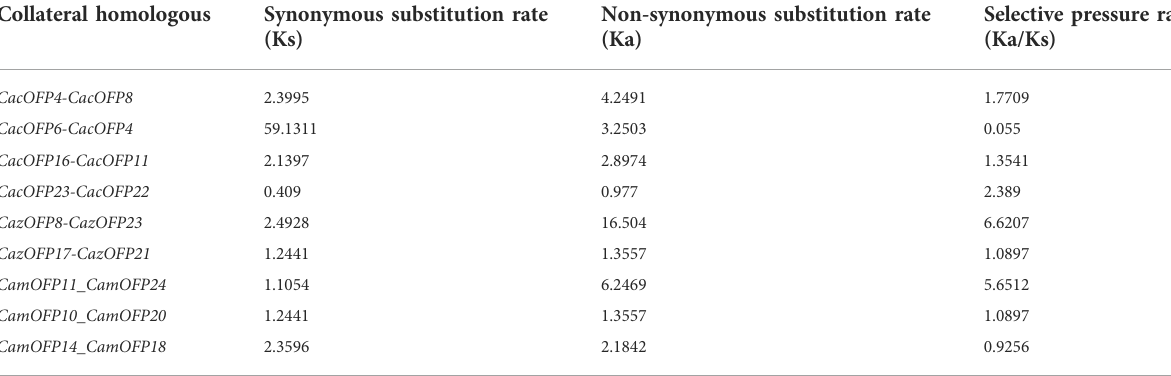
TABLE 2 Analysis of the evolutionary pressure of selection on the OFP genes in pepper. Collateral homologous Synonymous substitution rate (Ks)